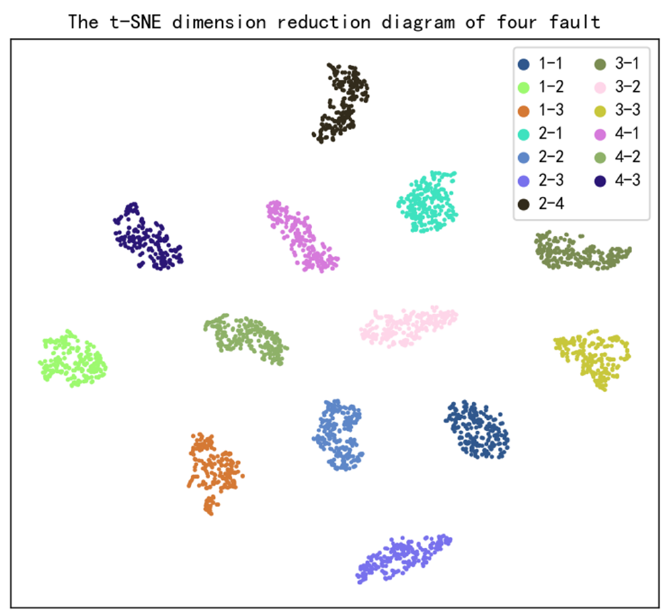
Figure 8. T-SNE dimension reduction diagram of multi-fault diagnosis network features.